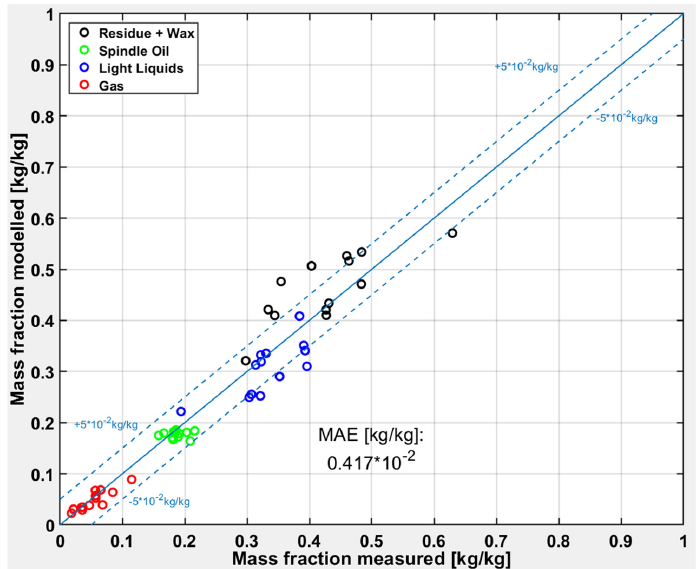
Figure 9. Deviation of the modeled and measured values of the test runs with carrier fluid and PP. “MAE” is the mean absolute error of the optimization of 0.42 × 10 − 2 kg/kg. The dashed lines show the 10% deviation.